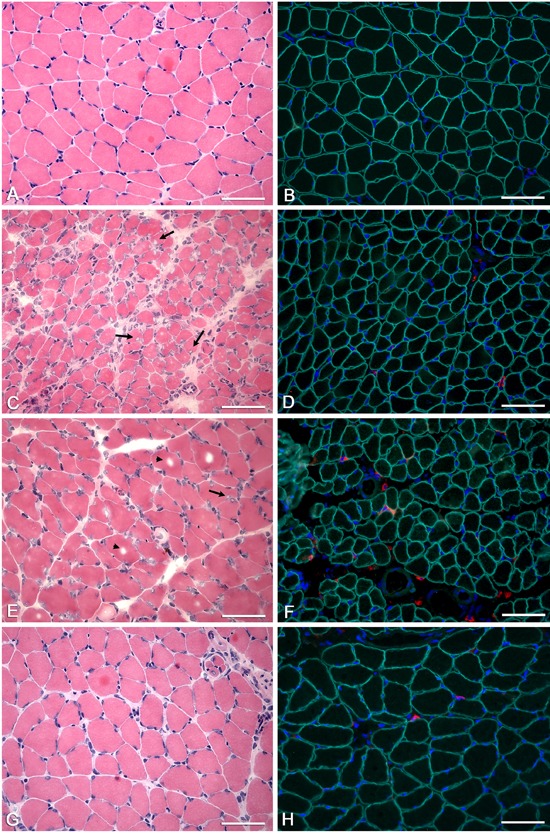
Photomicrographs of soleus muscle: hematoxylin-eosin (HE) staining and immunostaining for macrophages. Cross-sections of soleus muscle showing the general morphology (HE) and macrophage immunolabeling. A, C, E, G: HE staining; B, D, F, H: immunolabeling with rabbit anti-dystrophin (green) and mouse anti-CD68 (red) antibodies, and nuclear staining with DAPI (blue). A (CG30) and B (CG30) show polyhedral fibers and peripheral nuclei; C (IG) shows differences in fiber sizes, inclusion bodies (black arrow), central core lesion, and myonecrosis; D (IG) shows macrophage immunolabeling in the interstitial space; E (ISG) shows slight differences in fiber sizes, central cores (arrowhead), and inclusion bodies (black arrow); F (ISG) shows an increased number of macrophages; G (SG) and H (SG) show an absence of histopathological alterations. Bars: 50 µm. CG21: 21-day control group; CG30: 30-day control group; IG: immobilized group; ISG: immobilized and stretched group; SG: stretched group.